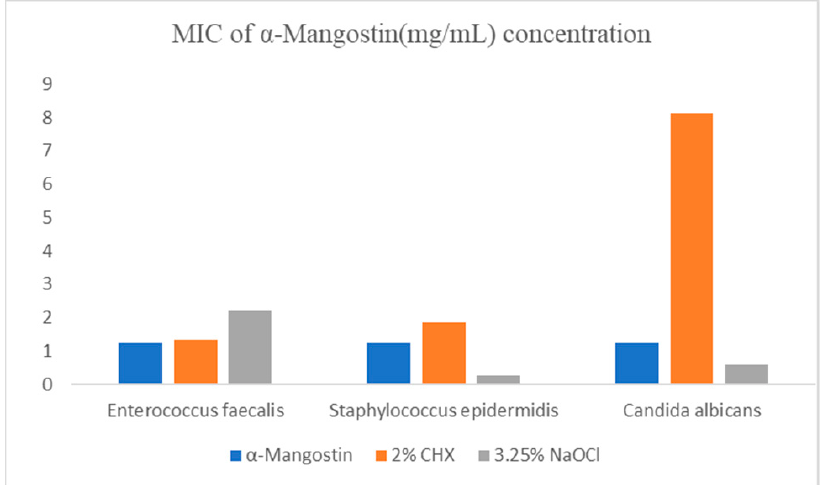
Figure 5. MIC of α -Mangostin(mg/mL) concentration against E. faecalis , S. epidermidis , and C. albicans . 3.5. Ex Vivo Experiment: Preparation of Human Teeth Specimens to Check the Antimicrobial Efficacy of PO-AMNE Irrigant in a Tooth Model Using Colony-Forming Units (CFU)